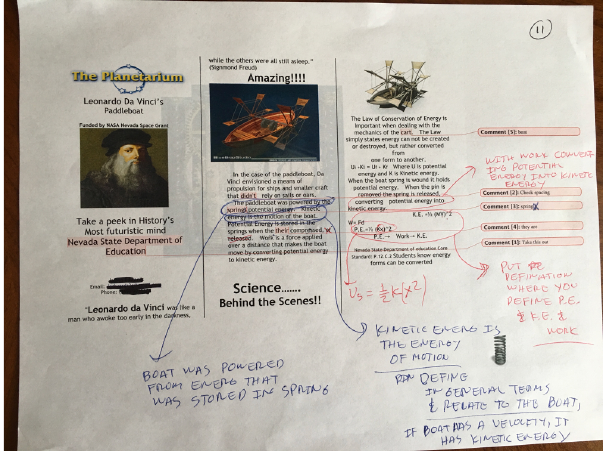
Fig. 1. The draft layout of a tri-fold brochure created by Jim (11F) describes the physics behind da Vinci’s paddleboat. Feedback was provided by the first author as shown by inserted digital text comments and by the professor as indicated by written comments in red and blue